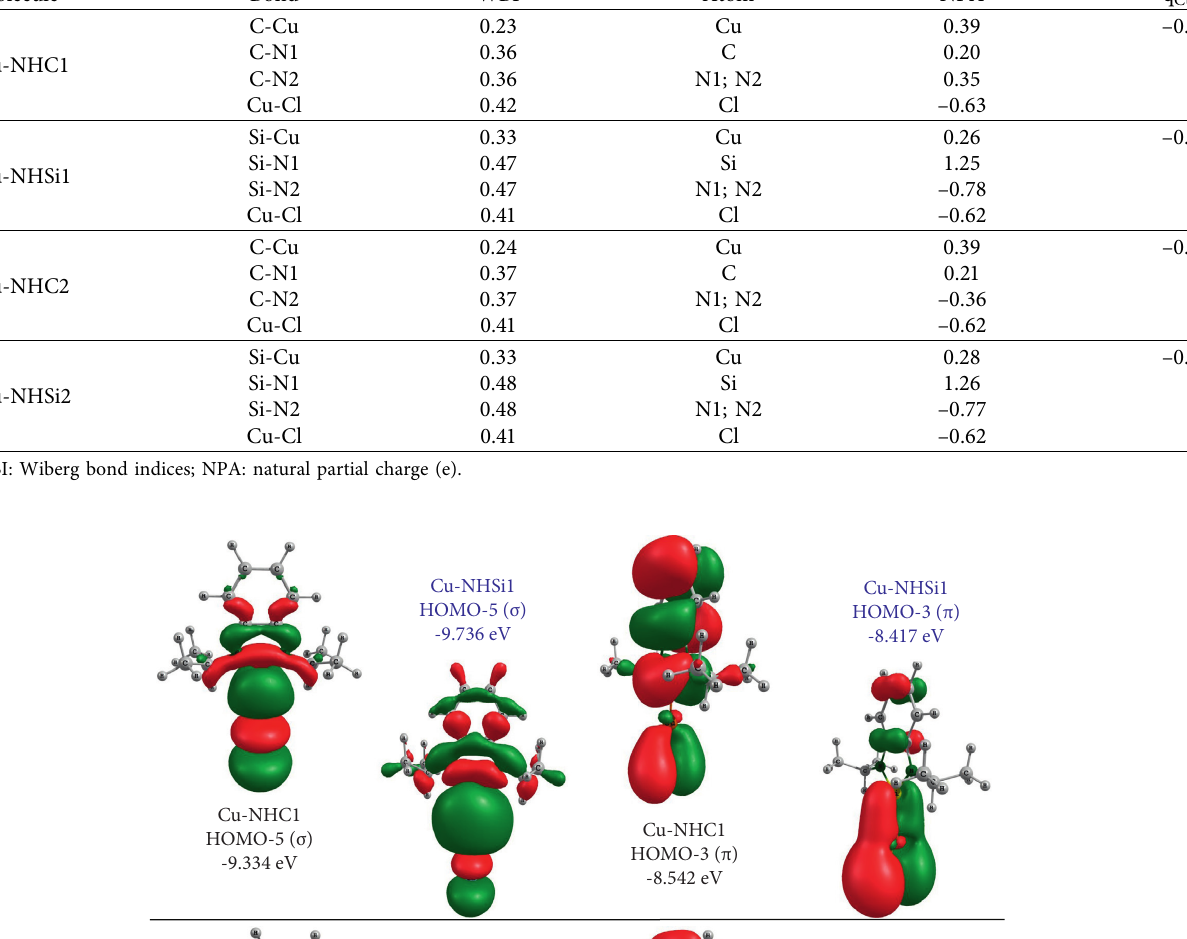
Table 1: Results of NBO analysis on copper carbenes and copper silylenes: Cu-NHC1, Cu-NHC2, Cu-NHSi1, and Cu-NHSi2 at the level of theory BP86/def2-TZVPP//BP86/def2-SVP.